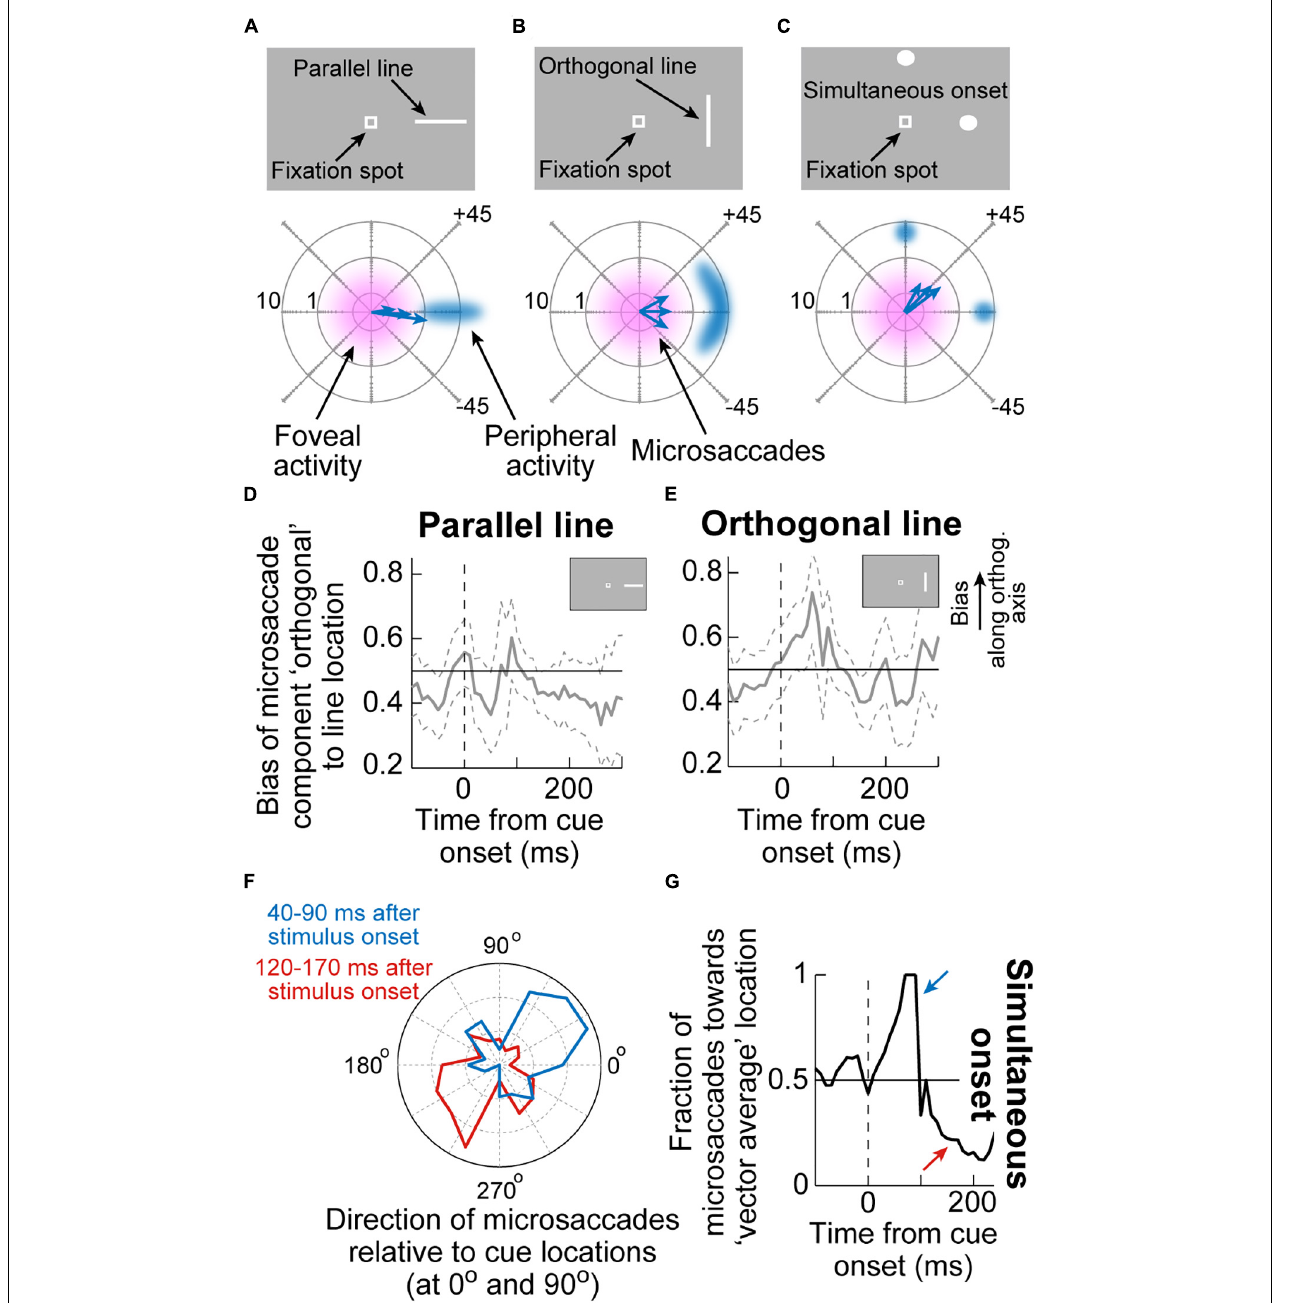
FIGURE 4 | Sensitivity of cue-induced microsaccade direction distributions to the spatial layout of peripheral cue configuration. (A) If the peripheral cue is spatially distributed as a parallel line relative to cue direction (top), as opposed to just a spot, then early cue-congruent microsaccades would exhibit endpoint variance along the axis of the appearing line. The bottom schematic shows how microsaccade endpoints, despite being foveal and not reaching the peripheral stimulus location, are still cue-directed, but exhibit variance along the orientation of the line. Eccentricity in the bottom schematic is plotted on a logarithmic scale to visually magnify the small amplitudes. (B) If the peripheral cue is at the same peripheral location but is oriented as an orthogonal line instead, then early cue-congruent microsaccades (bottom schematic) would have vertical variance reflecting the spatial extent of the peripheral stimulus. (C) In the extreme of two simultaneous onsets, spatial readout from a map like that of the SC for saccades would predict microsaccades to neither of the stimuli (bottom schematic). (D,E) The time course of microsaccade orthogonal bias for the configurations in (A,B) . For a parallel line (D) , there is no orthogonal bias. However, for an orthogonal line (E) , early cue-induced microsaccades directed toward the peripheral stimulus have increased orthogonal variance, as in (B) . (F) For a simultaneous stimulus onset, like in (C) , early cue-induced microsaccades (40–90 ms) are directed toward the vector average direction of the two stimulus locations, consistent with saccadic readout of SC map activity (Lee et al., 1988; Glimcher and Sparks, 1993; Port and Wurtz, 2003; Katnani et al., 2012). Later microsaccades (120–170 ms) are opposite the vector average location. (G) Time course of the effects in (F) . Adapted with permission from Hafed and Ignashchenkova (2013).